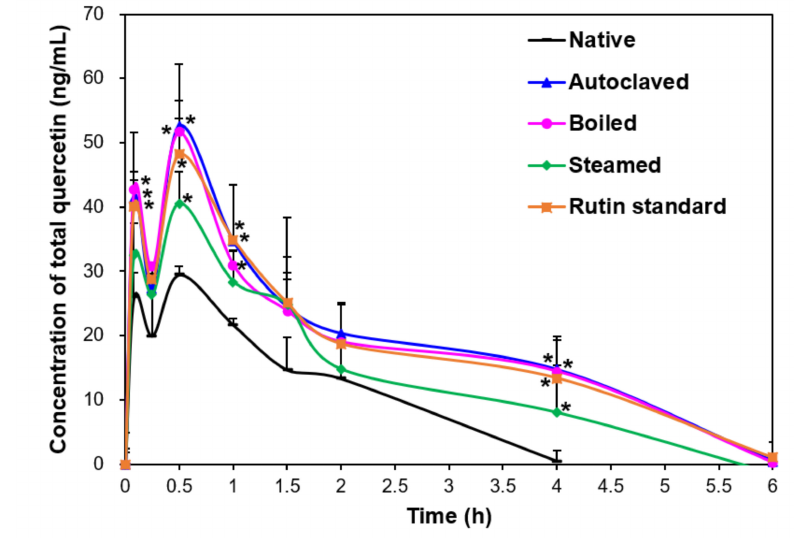
Figure 2. Plasma concentration-time curves of total quercetin after a single-dose oral administration of native, rutin-enriched TB flour extracts (TBFEs), and standard rutin in rats ( n = 6). Asterisk (*) indicates significant di ff erences from native TBFE at each time point ( p <